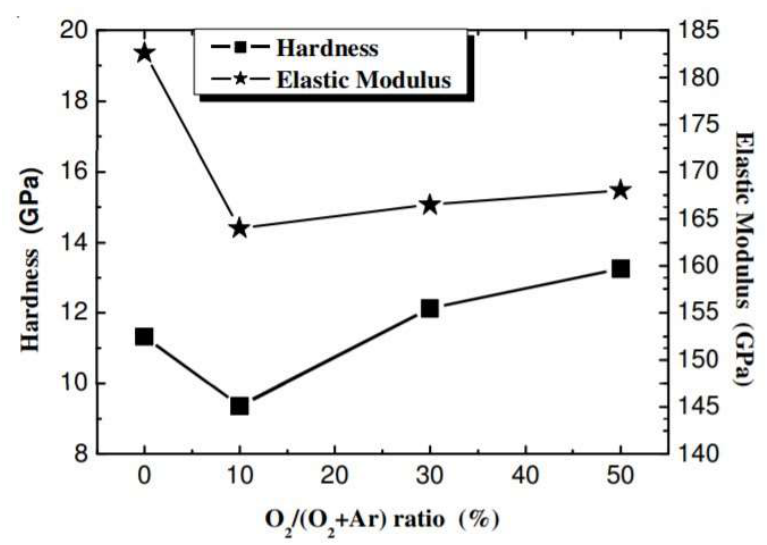
Figure 5. Variation in hardness and Young’s modulus with R O [48] (Creative Commons Attribution 4.0 International License).